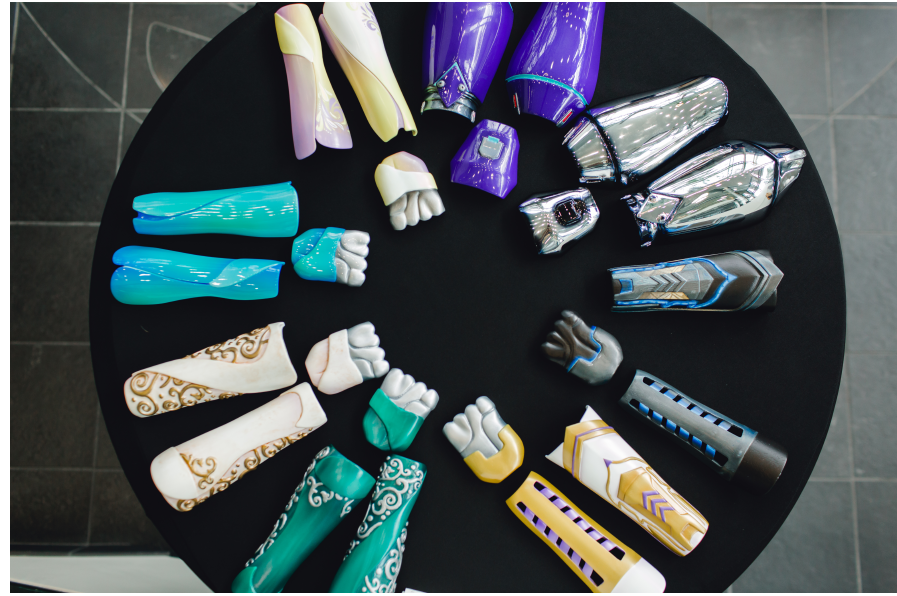
Figure 3. Completed interchangeable cosmetics components manufactured via additive manufacturing.